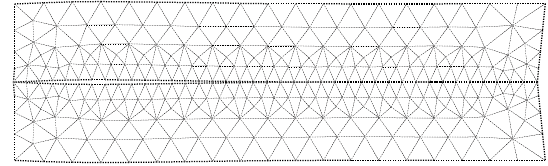
Figure 6.6 . Deformed configuration of the two elastic bodies.